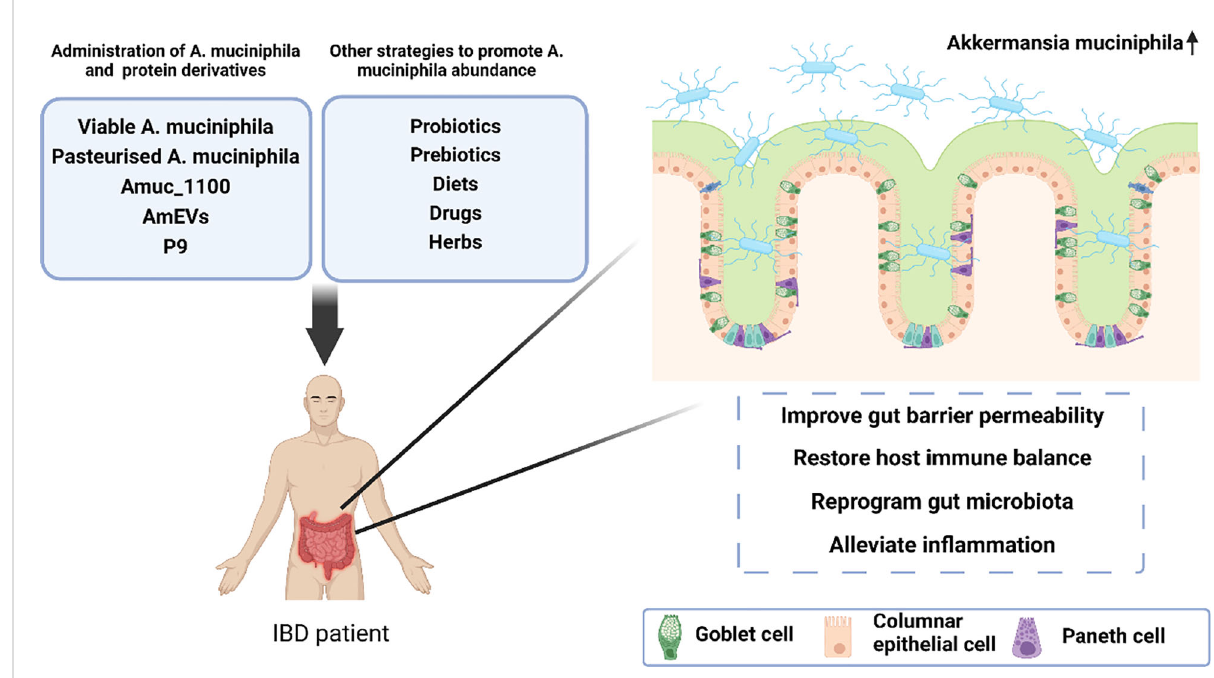
FIGURE 2 A proposed model illustrating the protective effect of A. muciniphila -targeted and -based therapies in the treatment of in fl ammatory bowel